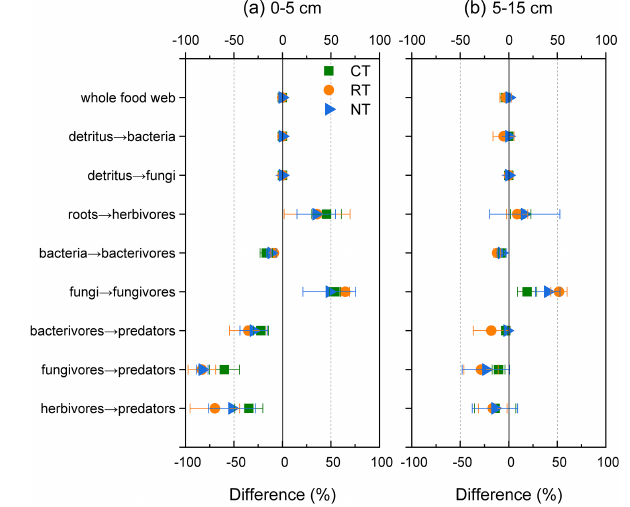
Figure 3. Differences (in percent) in the modelled mineral N de- livered by the food web between model 1 that assigned the om- nivorous collembolans into bacterivorous, fungivorous, herbivorous and predaceous collembolans in equal portions and model 2 that assigned the omnivorous collembolans into fungivorous and her- bivorous collembolans in equal portions. CT – conventional tillage; RT – reduced tillage; NT – no